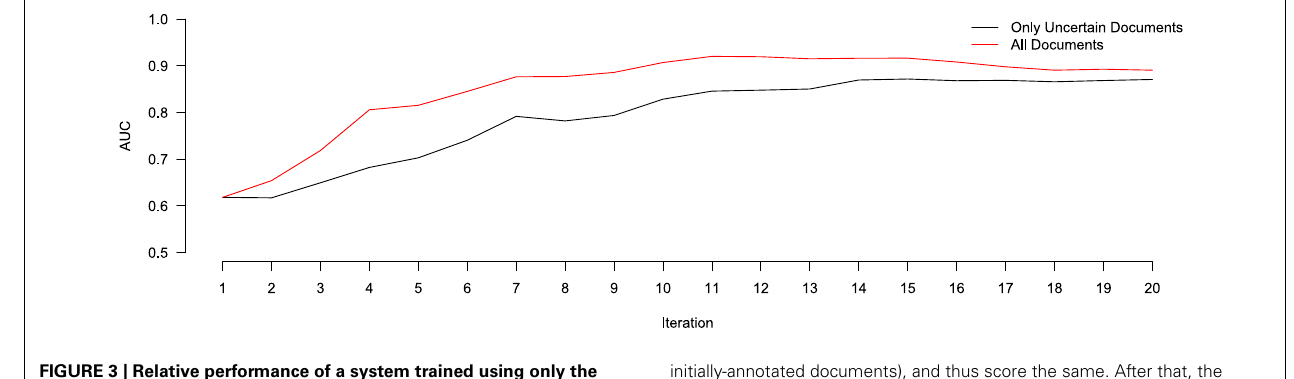
initially-annotated documents), and thus score the same. After that, the system trained using all the data consistently out-performs the one using only the uncertain data, though both begin to converge to similar values after 20 iterations.